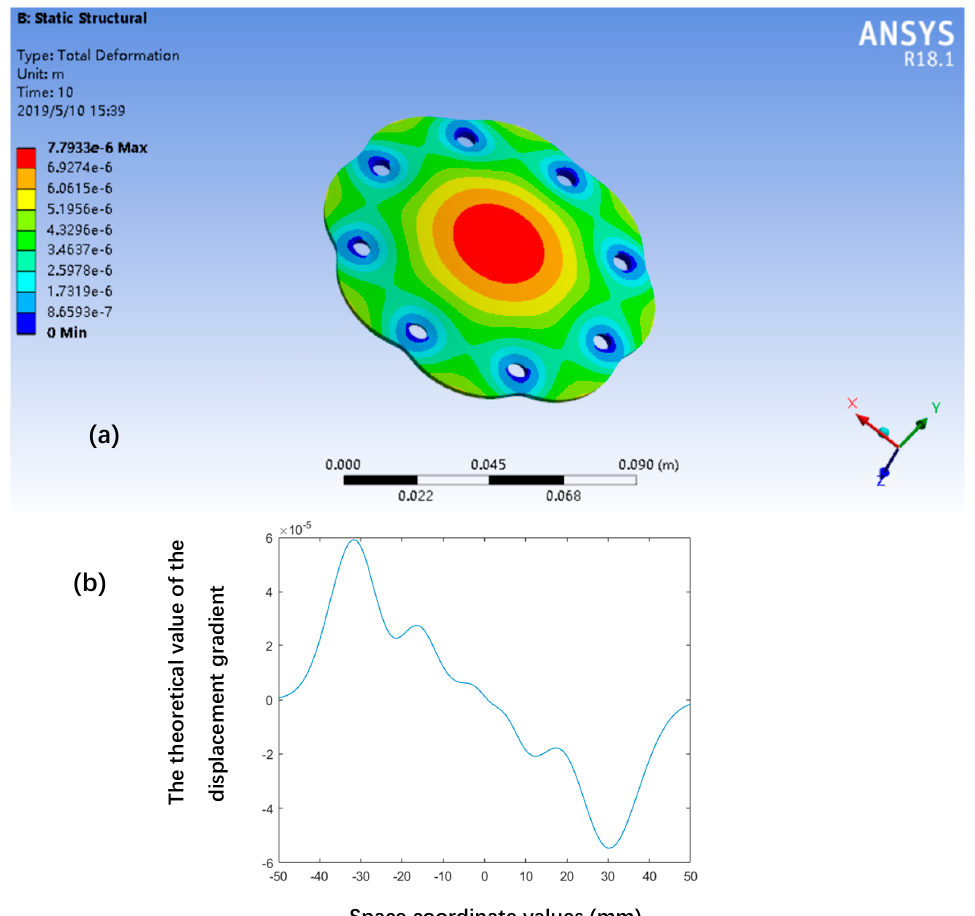
Figure 7. The model based on the finite element method (FEM) and the theoretical values: ( a ) displacement distribution, with the geometric center as the origin; and ( b ) the theoretical value of the displacement gradient along the